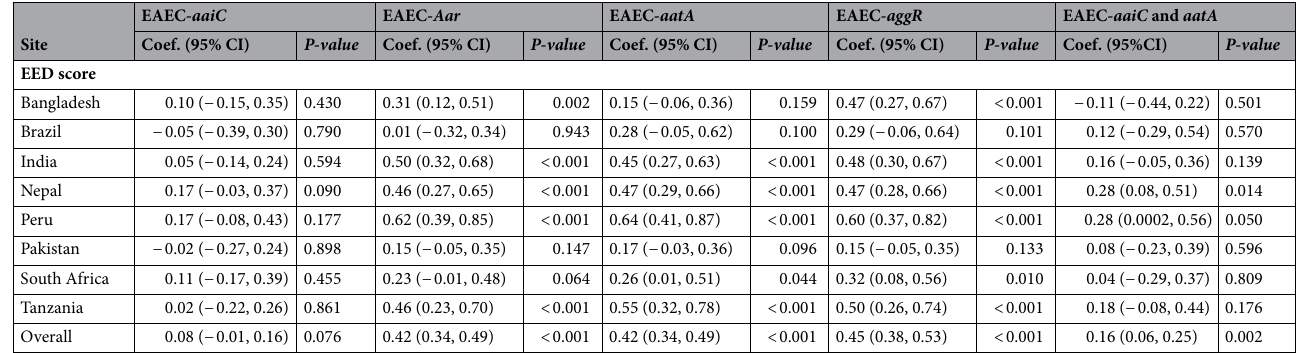
Table 5. Association between strain carrying genes of EAEC and EED score across each of the eight study sites (Bangladesh, India, Nepal, Pakistan, South Africa, Tanzania, Brazil, and Peru) from November 2009 to February 2012. Adjusted in GEE model for sex, age, WAMI Index (water/sanitation, assets, maternal education, and income); enrollment length-for-age z score; maternal BMI; the number of children, poultry/ cattle in house, seasonality, serum zinc level, AGP (alpha-1-acid glycoprotein), presence of co-pathogens ( Campylobacter , LT-ETEC, ST-ETEC, Shigella /EIEC, and Giardia ), site for the overall estimate, and age as the time variable. EED score (AAT = alpha-1-anti-trypsin; MPO = myeloperoxidase; NEO = neopterin) Coef.: Coefficient; CI: Confidence interval The dependent variable was log (MPO, NEO, and AAT); Independent variables: the presence of strain carrying genes associated with EAEC at each